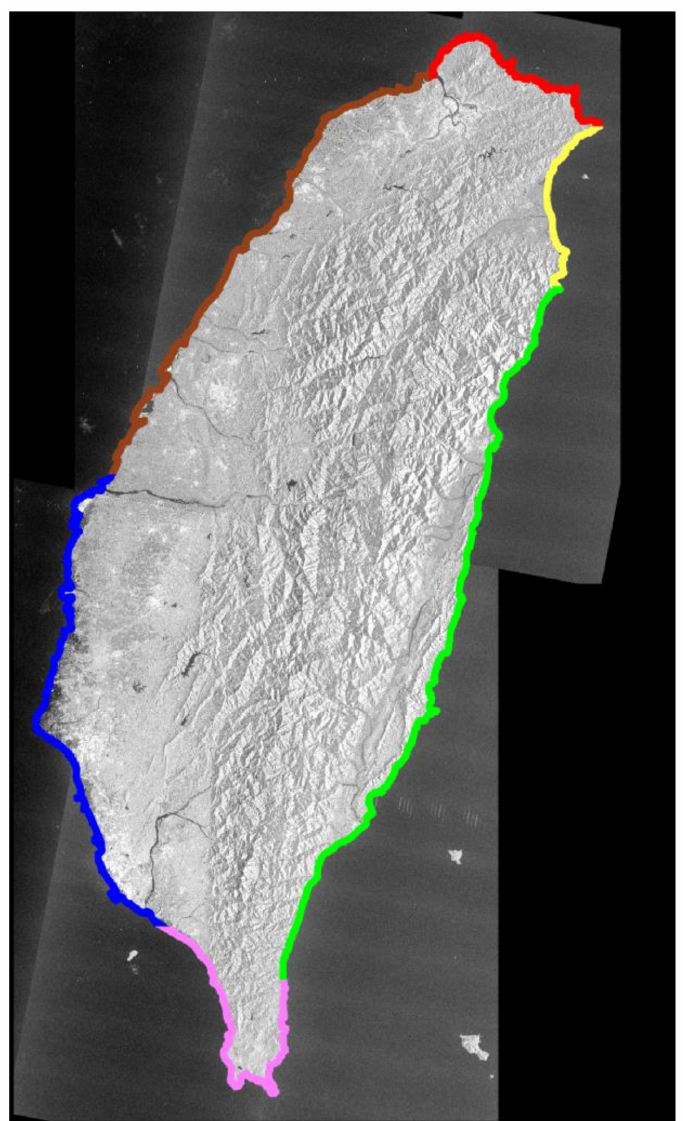
Figure 11. Detection result of the entire shoreline of Taiwan. North in red, northeast in yellow, east in green, south in pink, southwest in blue, and northwest in